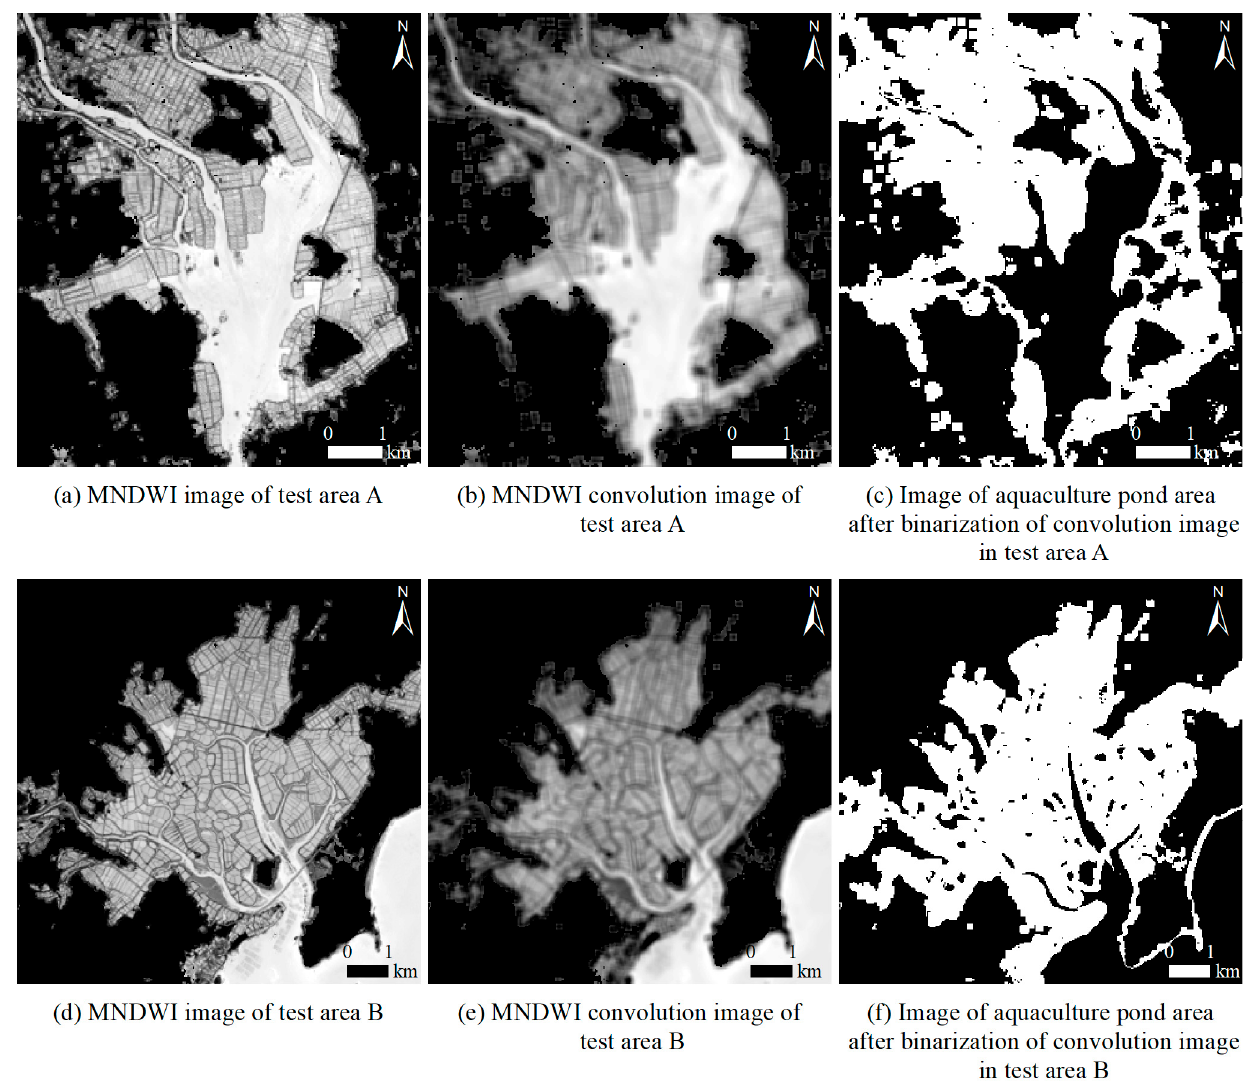
Figure 9. Extraction of aquaculture water in test area A (B).